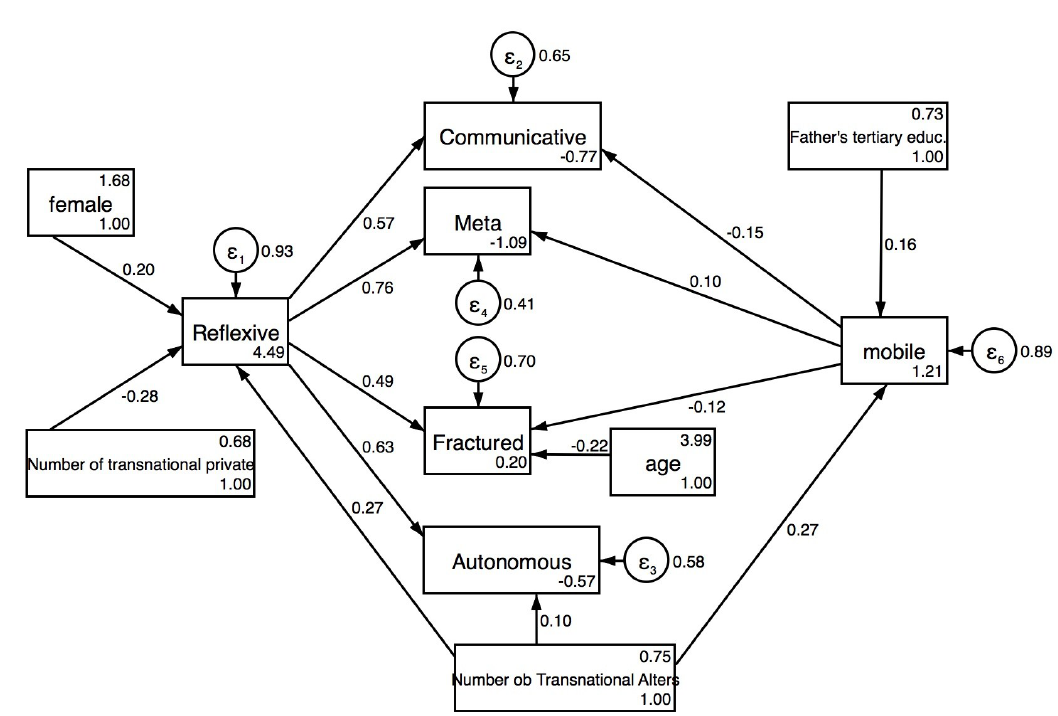
Figure 1. Path analysis explaining the relationships between mobility, inclusion in the transnational sphere, levels, and types of reflexivity and background variables. Table 5. Path analysis: variables, coefficients, and overall model